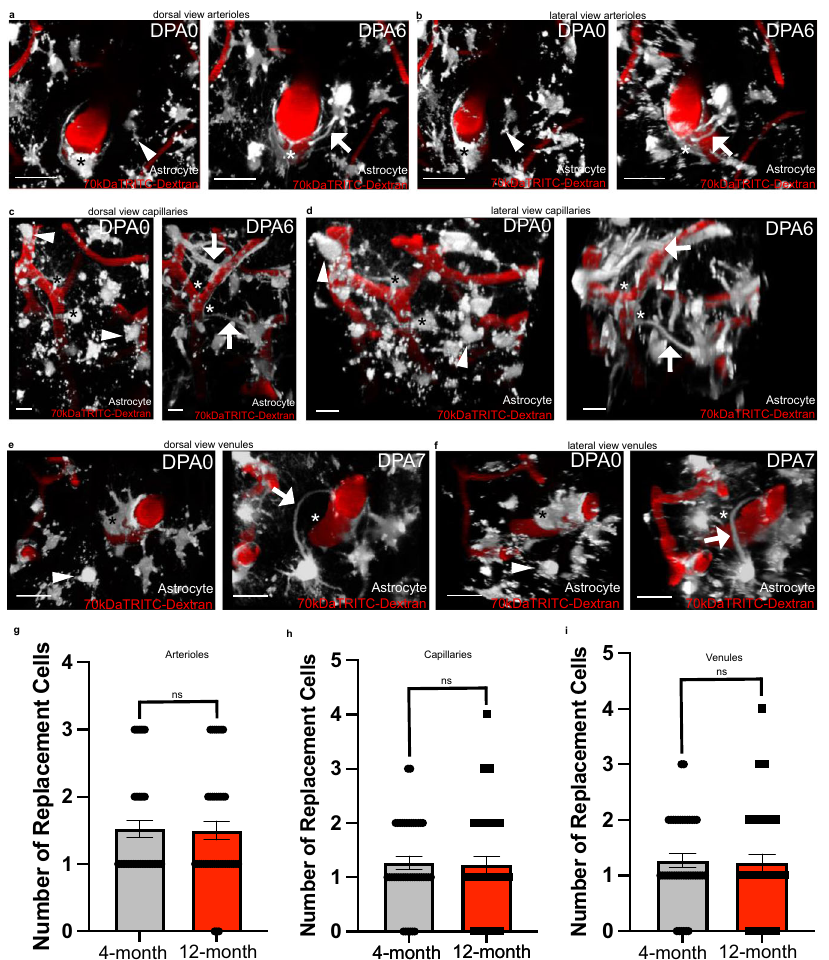
Fig. 3 Gliovascular structural plasticity remains intact at all levels of the vascular tree in aging. In order to determine if gliovascular structural plasticity remained intact in aging, we ablated astrocytes in 12-month-old Aldh1l1-eGFP mice making contact with Alexa 633 hydrazide positive penetrating arterioles, capillaries, and venules. We further compared the extent of replacement in old versus young mice as well. In all images, asterisks indicate the ablated astrocyte(s) (shown in gray, blood vessels are in red), arrow heads indicate the eventual replacement astrocyte, and arrows demarcate replacement processes. Volumetric reconstruction showing astrocyte associations with a penetrating arteriole at dpa0 (left) and dpa6 (right), from a a dorsal perspective and b a dorsolateral perspective. Scale bar = 25 µ m. n = 40 astrocytes across 6 mice. c and d Volumetric reconstruction showing astrocytes and their association with a capillary at dpa0 (left) and dpa6 (right) from c a dorsal view and d a dorsolateral view. Scale bar = 10 µ m. n = 40 astrocytes over 4 mice. Volumetric reconstruction showing an ascending venule and astrocyte interactions with it at dpa0 (left) and dpa7 (right), from e a dorsal view and f a dorsolateral view. Scale bar = 20 µ m. n = 40 astrocytes across 5 mice. g Average number of replacement astrocytes (the number of cells extending processes to vascular vacancies) in 4- versus 12-month old mice at arterioles, Two-tailed Mann – Whitney test, p = 0.9465, n = 40 cells examined over 7 mice for 4-month data, n = 40 cells examined over 6 mice for 12-month data. h Average number of replacement astrocytes in 4-versus 12-month old mice at capillaries, Two-tailed Mann – Whitney test, p = 0.6853, n = 40 cells examined over 4 mice for both 4- and 12-month old mice. i Average number of replacement astrocytes in 4-versus 12-month old mice at venules, Two-tailed Mann – Whitney test, p = 0.3060, n = 40 cells examined over 7 mice for 4-month old data, n = 40 cells examined over 5 mice for 12-month old data. Data are presented as mean values ± SEM. LUTs have been adjusted to emphasize the replacement astrocytes and associated